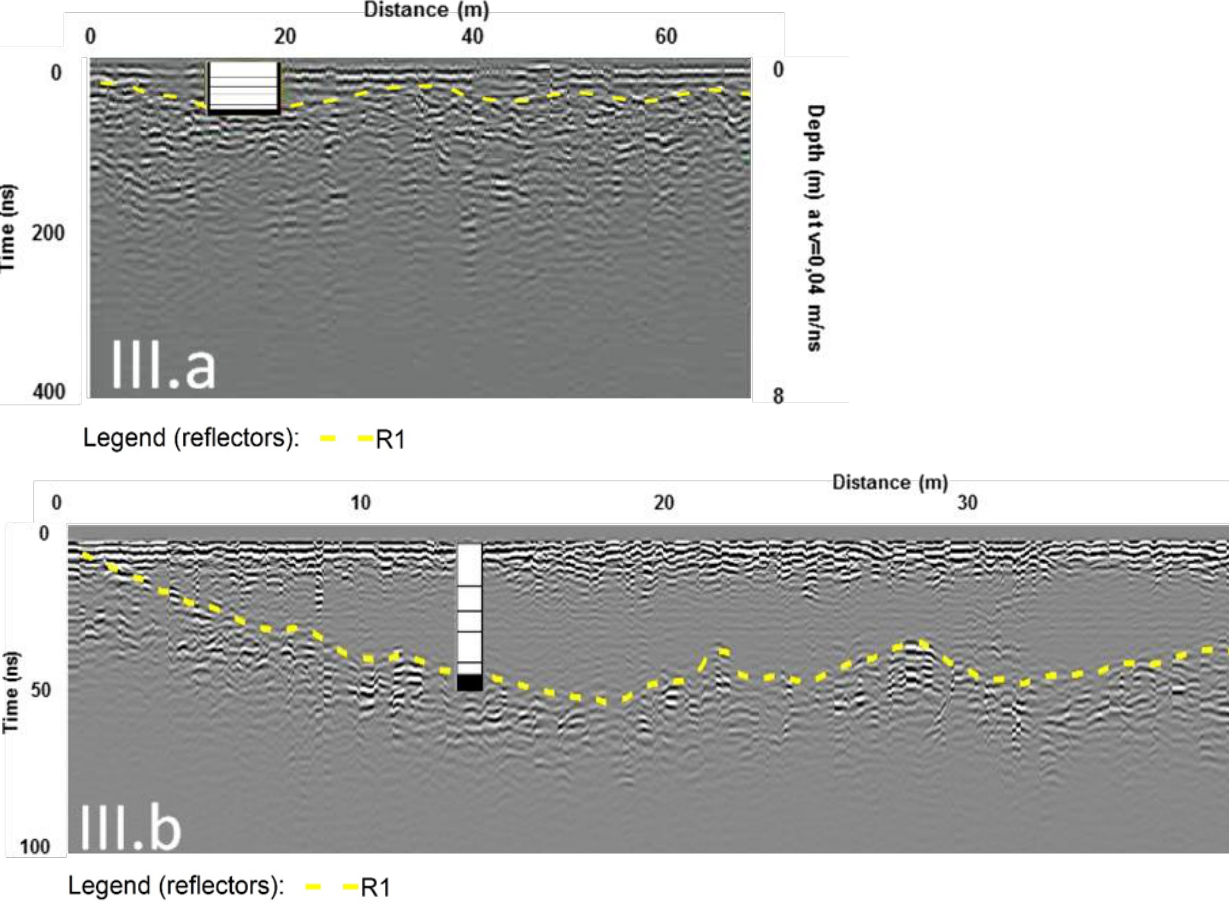
Figure 9. Peat Bog III: example radargrams produced using the 100 MHz antenna (above) and the 500 MHz antenna (below). The transect selected includes the open core (see Figure 4 for more information). The dashed lines indicate interpreted reflections in the GPR